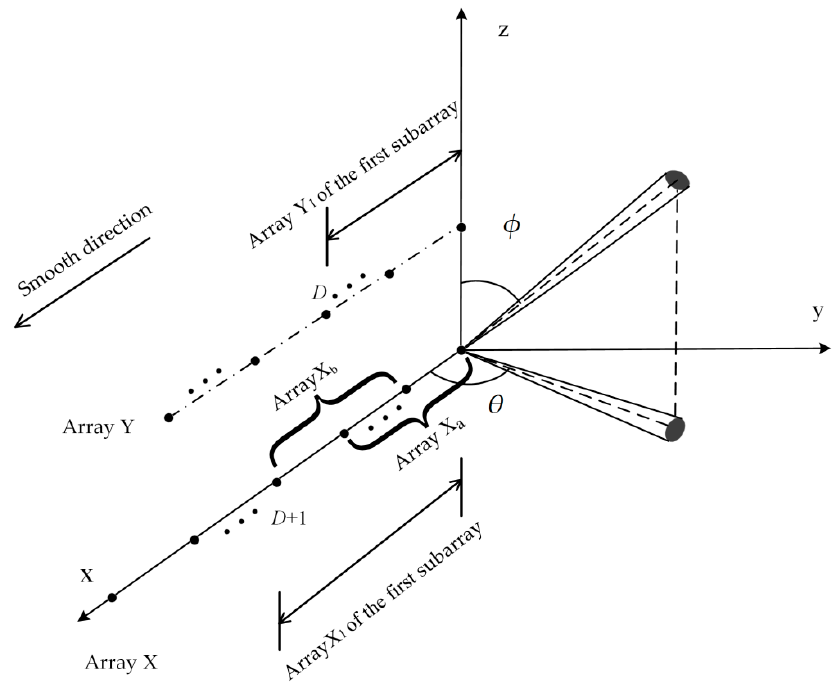
Figure 1. The double parallel linear arrays.